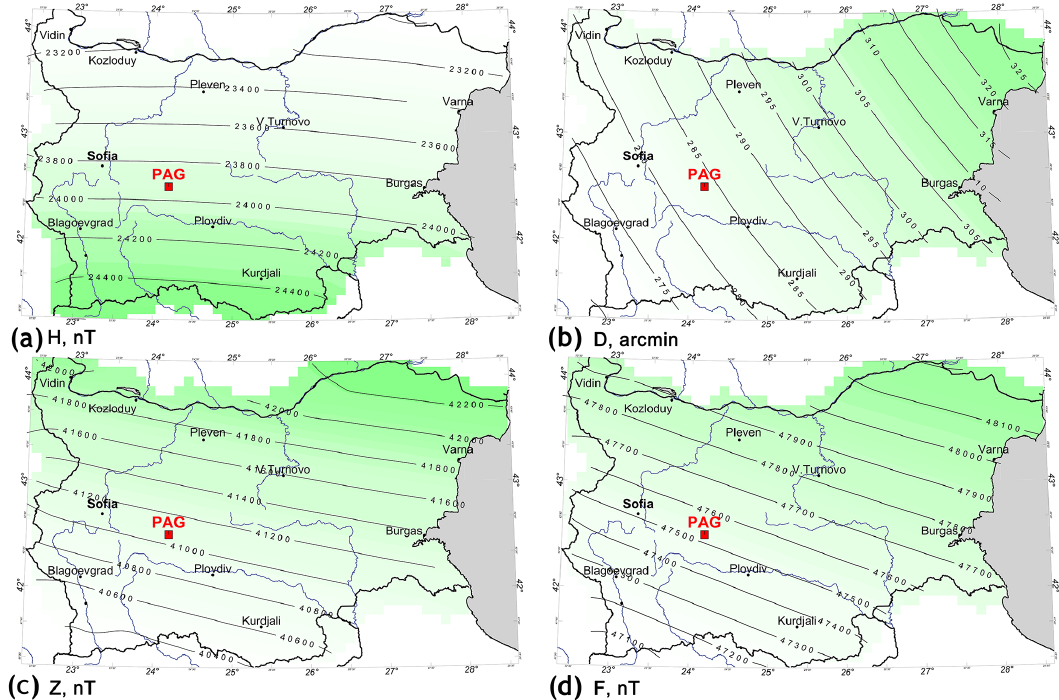
Figure 5. Maps of the modelled geomagnetic field elements of BulGRF epoch 2015.0: (a) H (nT); (b) D (arcmin); (c) Z (nT); (d) F (nT).